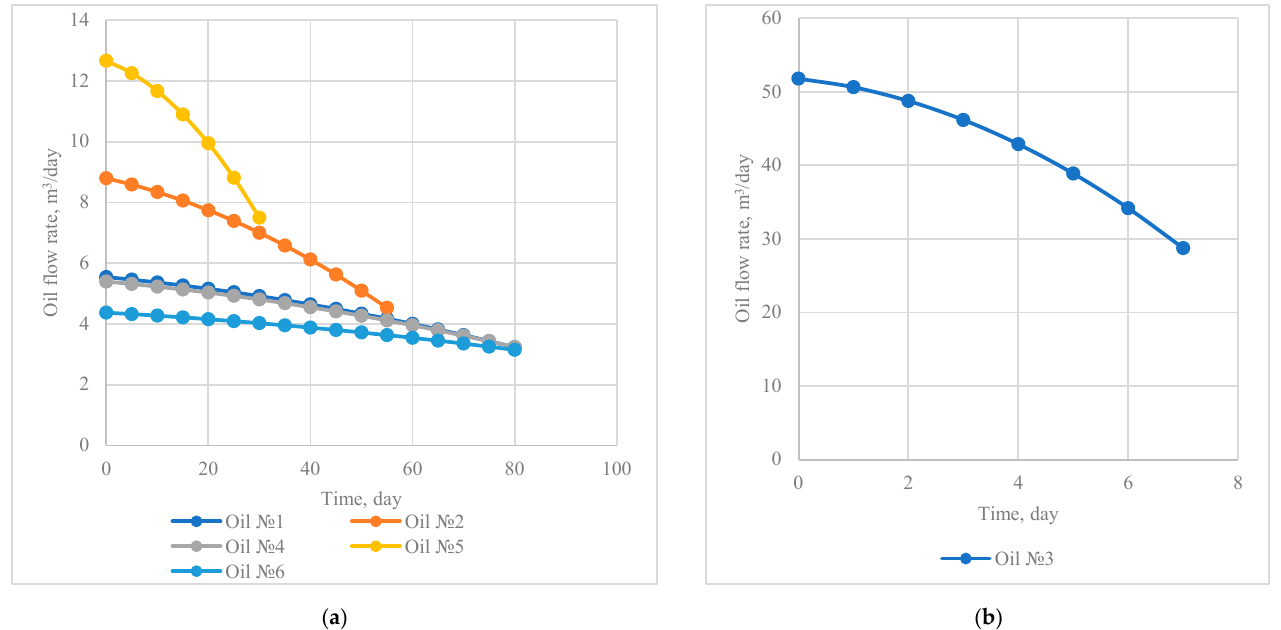
Figure 3. Dependency of oil flow rate on time, factoring in the cooling of previously heated near- wellbore area: ( a ) for oil № 1, 2, 4, 5, 6; ( b ) for oil № 3. As seen from the results obtained for the oil with the lowest viscosity (oil № 3), the highest flow rates are observed before and after the steam stimulation, yet this, in turn, results in the rapid cooling and flow rate reduction to the initial rate. Rather high flow rates for low-viscosity oil are explained by the fact that the same reservoir properties were used for all calculations, aiming to determine the limits of applicability of the near-wellbore cyclic steam simulation technology by correlation dependency of the oil dynamic viscosity on temperature. For oil samples with the highest viscosity at reservoir temperature, the lowest flow rates are observed. However, for more viscous oil, the processes of oil cooling and, consequently, increase in viscosity occur more slowly, which in turn means maintenance of the increased flow rate for a longer period of